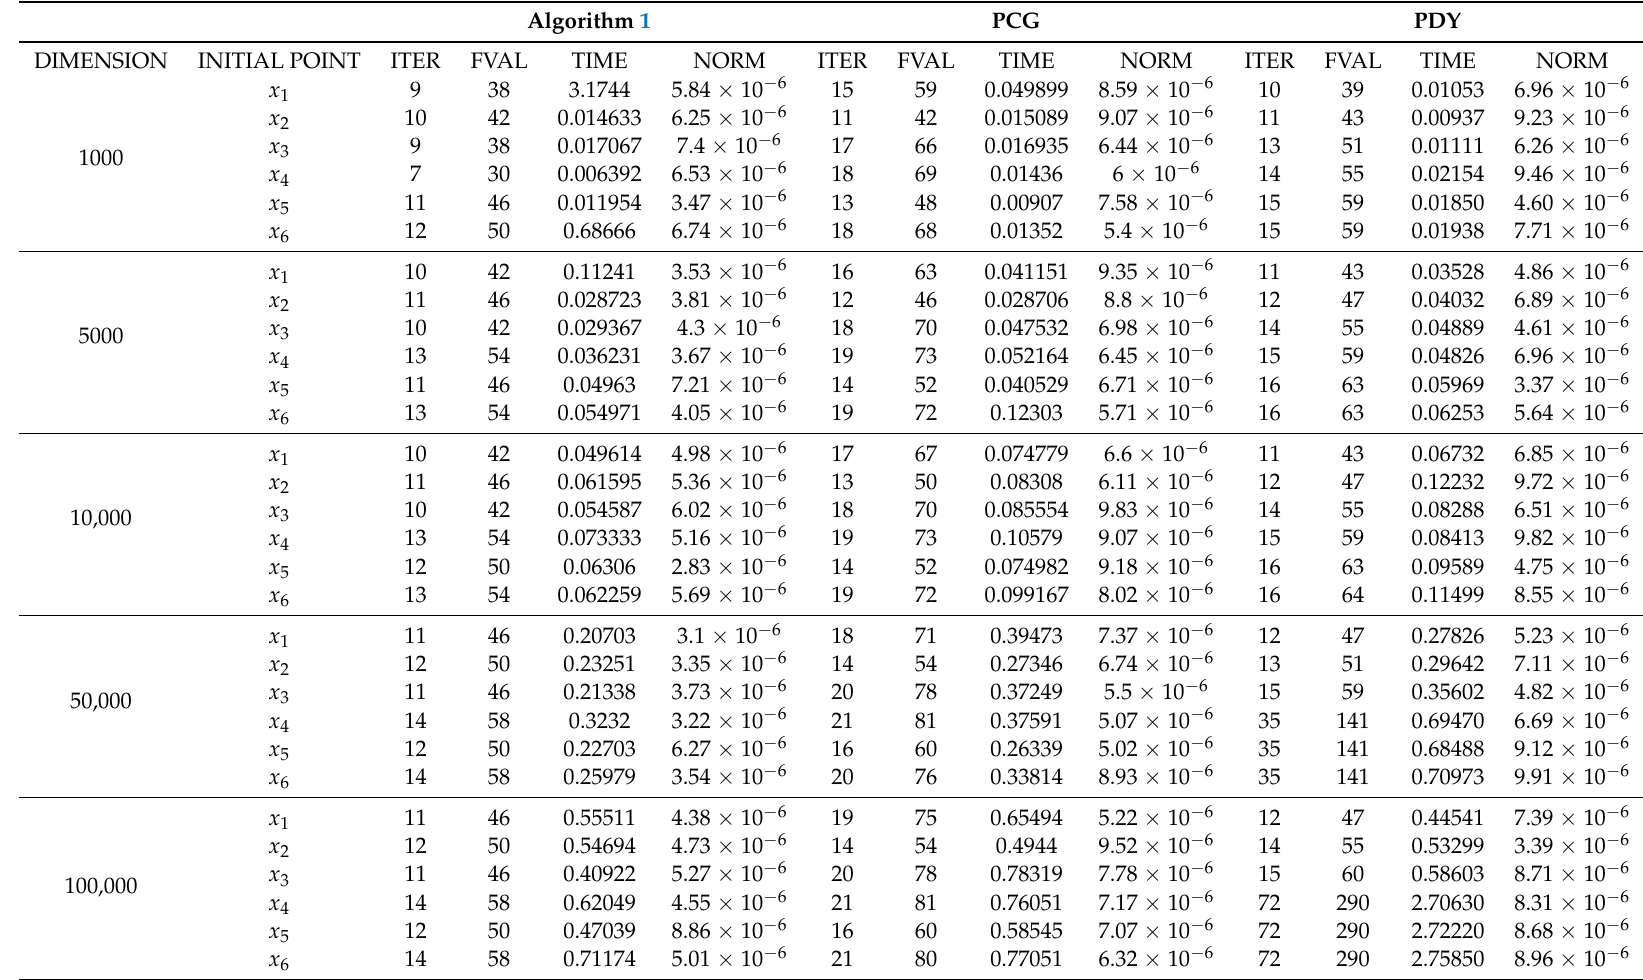
Table 2. Numerical Results for Algorithm 1 (DCG) , PCG and PDY for Problem 2 with given initial points and